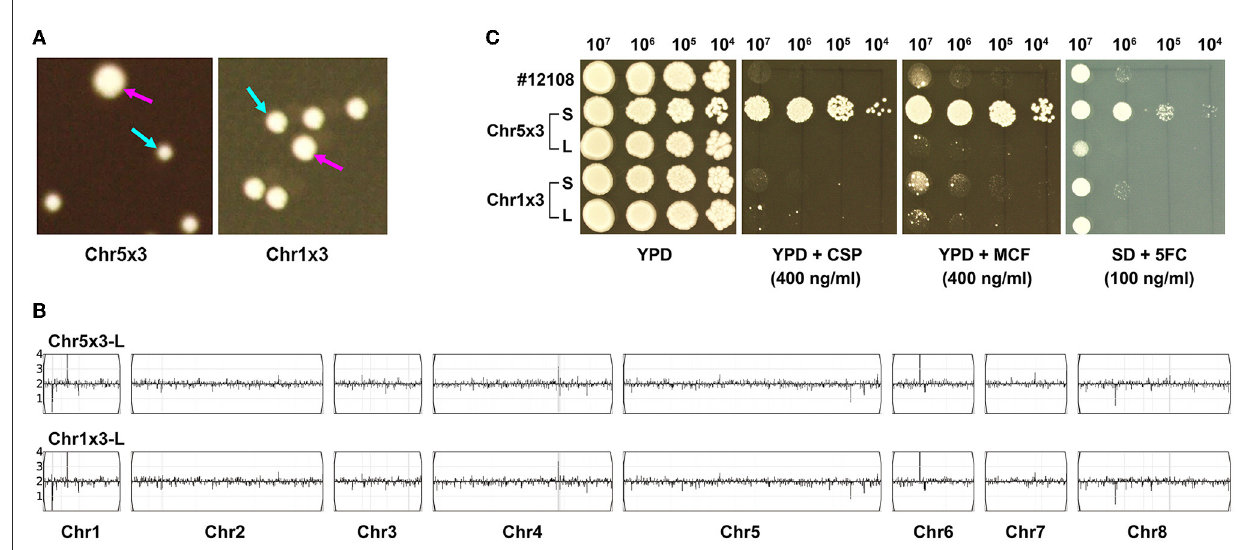
FIGURE4 Genome and phenotype instability of aneuploids. Approximately 200 cells of aneuploid adaptors were spread on YPD plates. The plates were photographed after 72h of incubation at 37 ◦ C. Cyan arrows indicate small (S) colonies and magenta arrows indicate large (L) colonies (A) . The L colonies were sequenced, and the karyotypes were visualized using Ymap (B) . For each adaptor, S and L colonies were compared for tolerance to caspofungin (CSP), micafungin (MCF), and 5-flucytosine (5FC) (C) . Spot assays were performed using YPD plates supplemented with CSP or MCF, and the SD plate supplemented with 5FC. The plates were incubated at 37 ◦ C for 72h and then photographed.